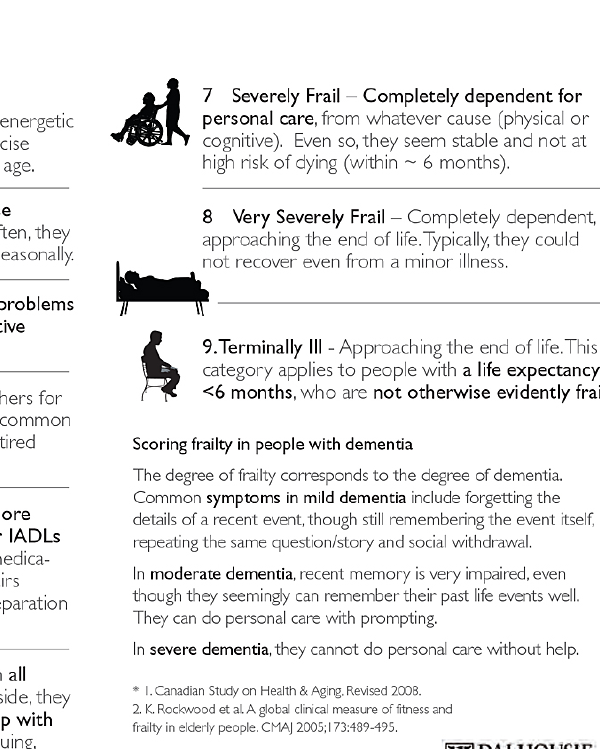
Figure 1: Clinical Frailty